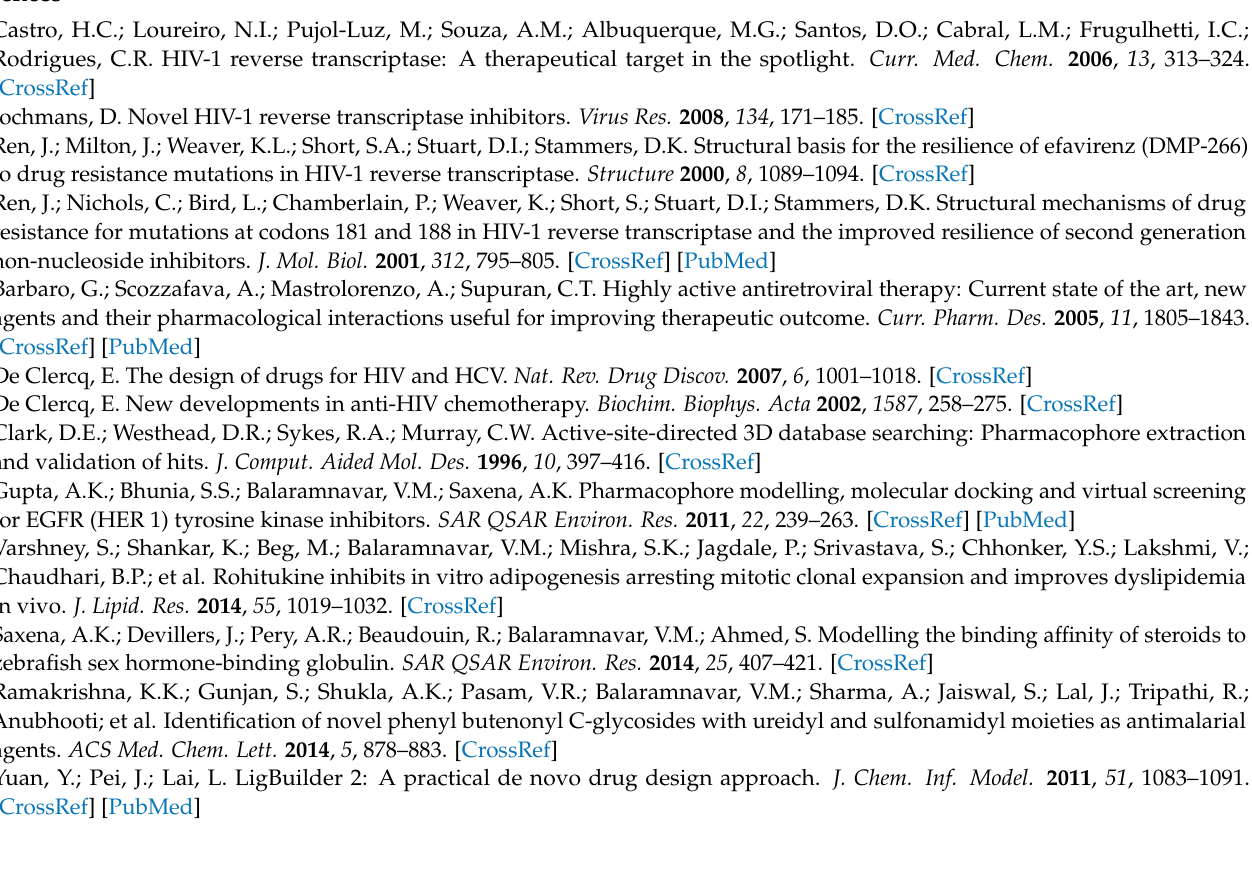
Supplementary Materials: Figure S1. The ligand pharmacophore mapping of the external test set of compounds on the pharmacophore model. Table S1. Scores and data related to training set. Table S2. Test set prediction on training set pharmacophore. Table S3. Mapping of standard compounds and estimated activities using hypothesis